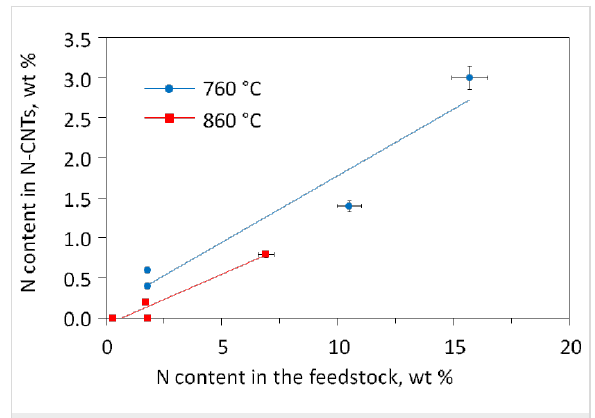
Figure 2: Relationship between the nitrogen content in the N-CNTs products and in the feedstock.